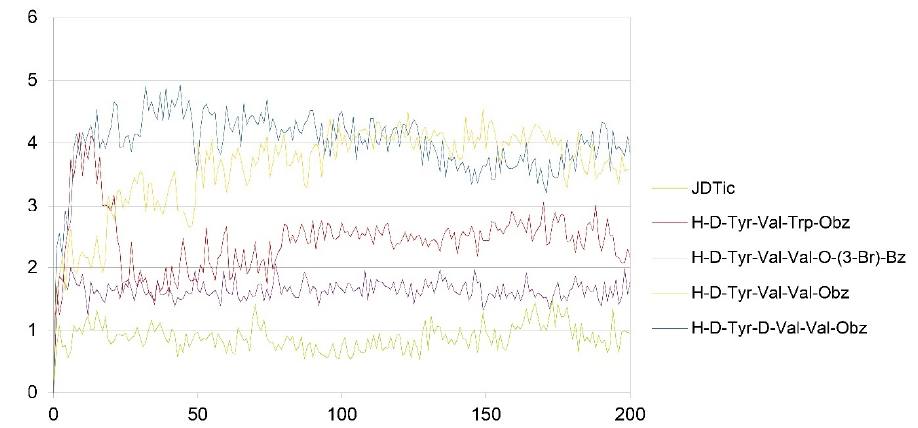
Figure 3. RMSD values of JDTic and the designed peptides (x axis: RMSD in Angstrom; y axis: time in ns).